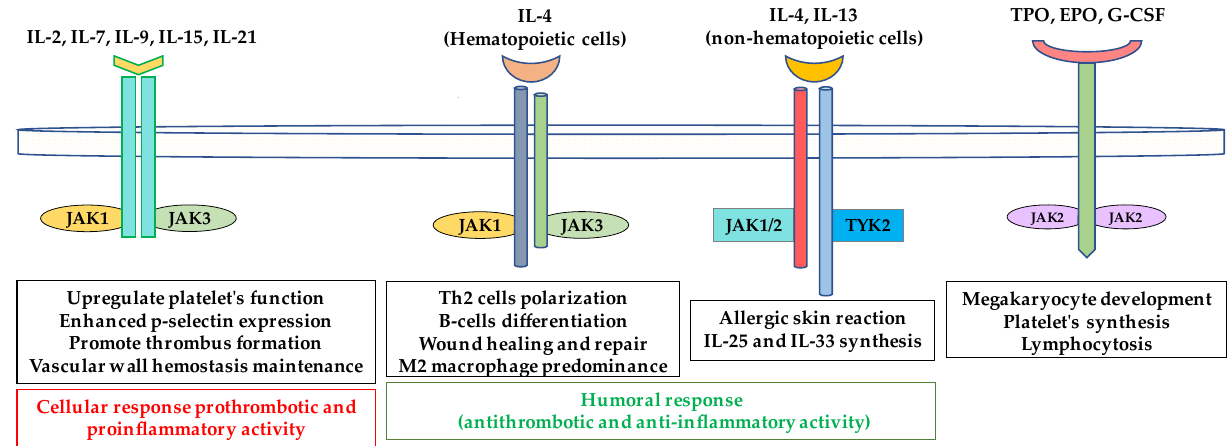
Figure 3. Pro and anti-thrombotic activities of cytokines. Cytokines which signal through the common gamma chain receptor family, and hematopoietins (TPO, EPO and G-CSF) transmit proinflammatory and prothrombotic signals resulting in higher expression of adhesion molecules, vascular wall inflammation and platelet synthesis, which promote thrombus formation. IL-4 and IL-13 are involved in the humoral response, antibody synthesis and lymphocyte polarization toward the Th2 response, thus playing anti-inflammatory roles. Multiple cytokines signal via the same JAK, thus blocking any single JAK may simultaneously inhibit transmission of multiple pro- and anti-thrombotic signals. TPO, thrombopoietin; EPO, erythropoietin; G-CSF, granulocyte-colony stimulating factor.